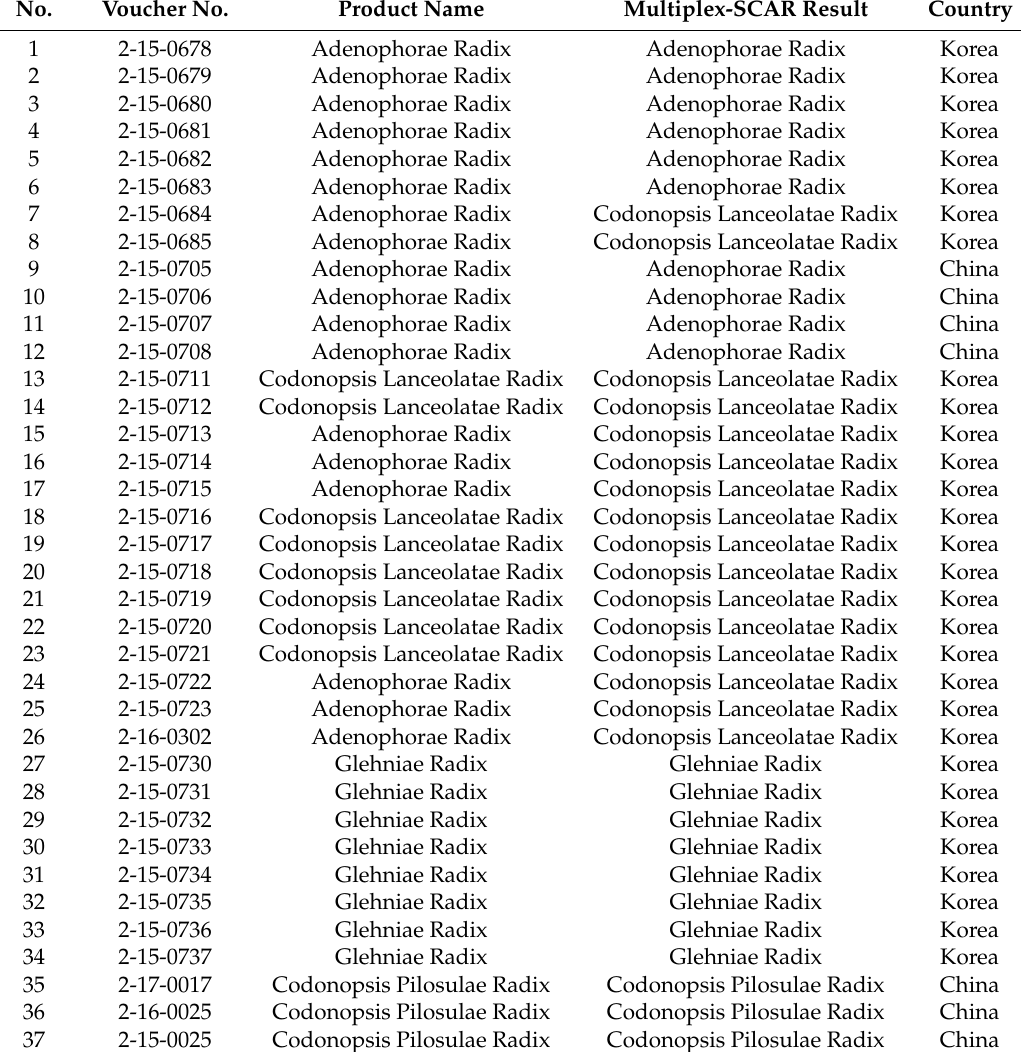
Table 4. Sample information and monitoring results of the 37 commercial herbal medicines assessed using our multiplexed SCAR